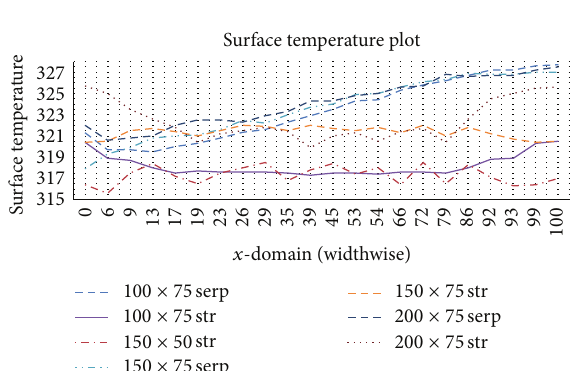
Figure 13: Surface temperature collection line and water inlet and outlet region in straight pipe arrangement.